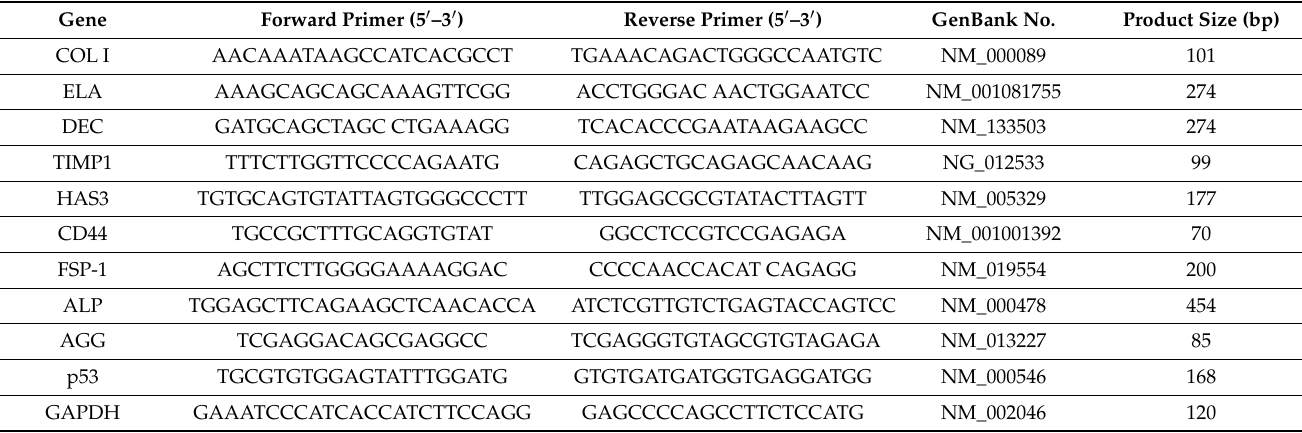
Table 1. Primers used for determining fibroblastic differentiation using quantitative real-time PCR.